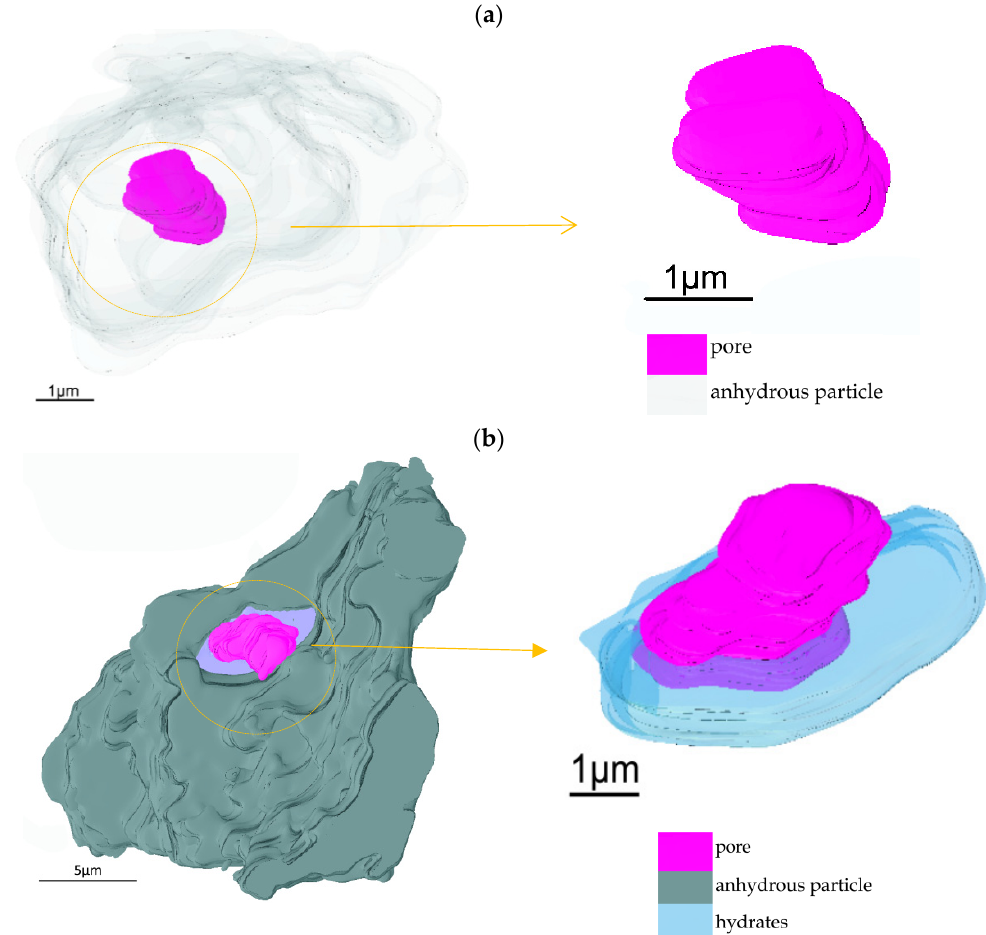
Figure 5. Two types pores in the anhydrous C 3 S particles: ( a ) closed pores and ( b ) open